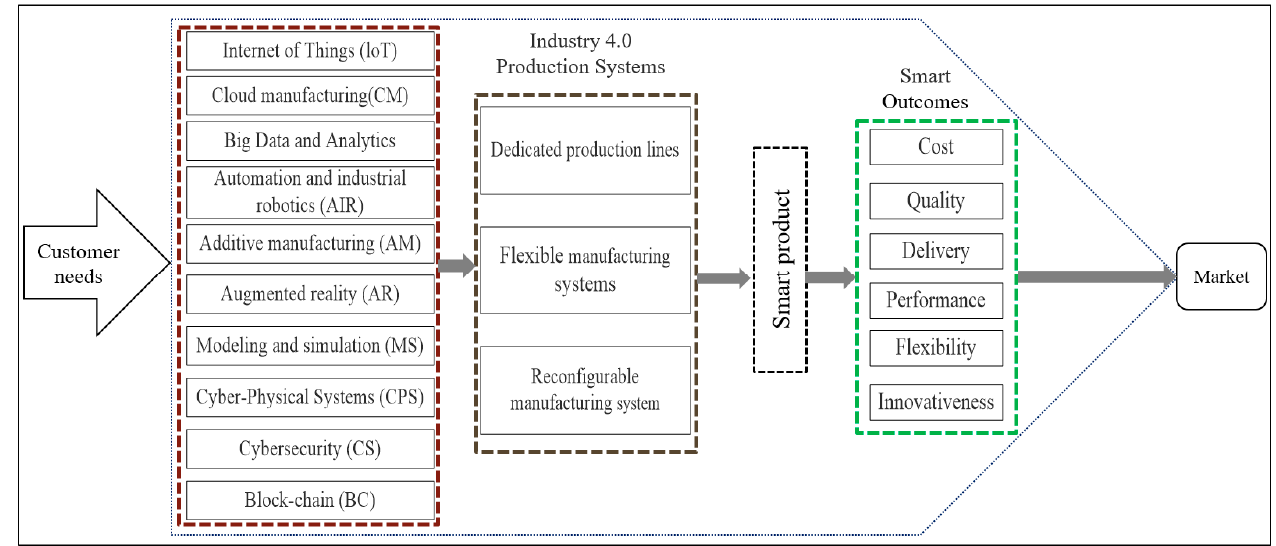
Figure 1. Smart manufacturing framework.